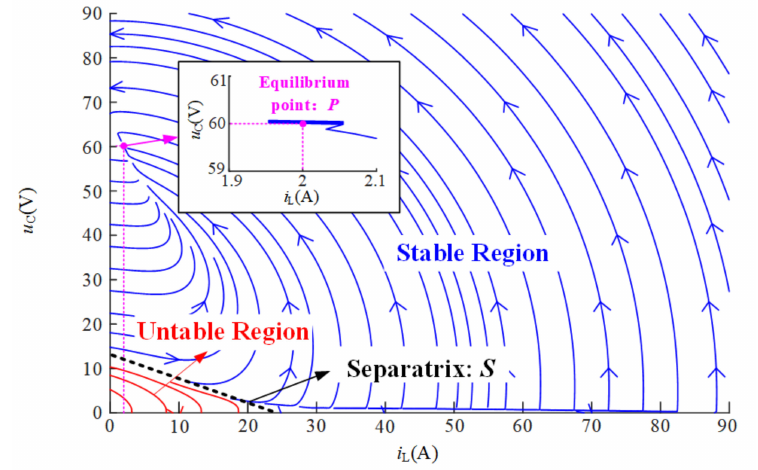
Figure 11. Phase portrait of DDBC by using IPBC when feeding CPL.